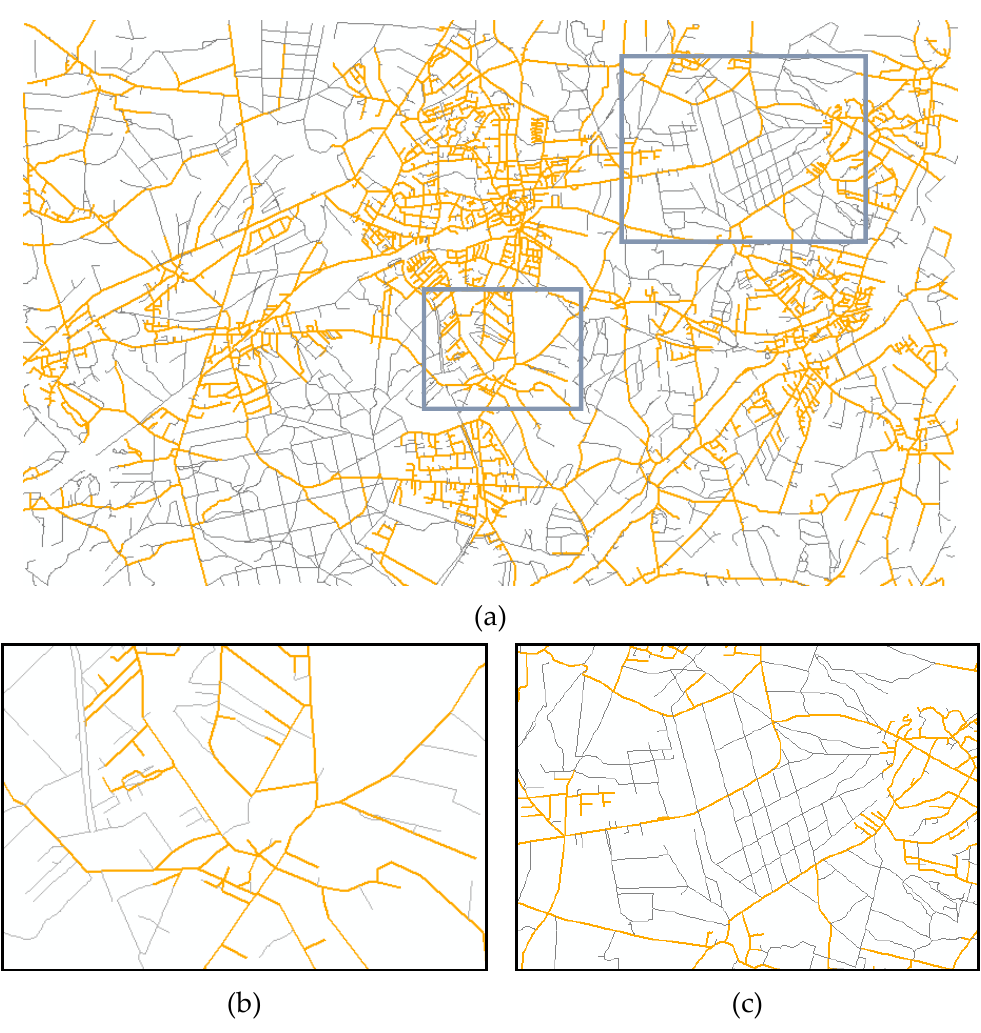
Figure 10. An example of the conflated road network in a suburb area: ( a ) a randomly selected area of 15 × 10 km 2 in Hamburg, Germany; ( b ) partial enlarged view of (a); ( c ) partial enlarged view of (a). Orange: the initial road network of NAVTEQ; grey: the conflated roads from ATKIS.